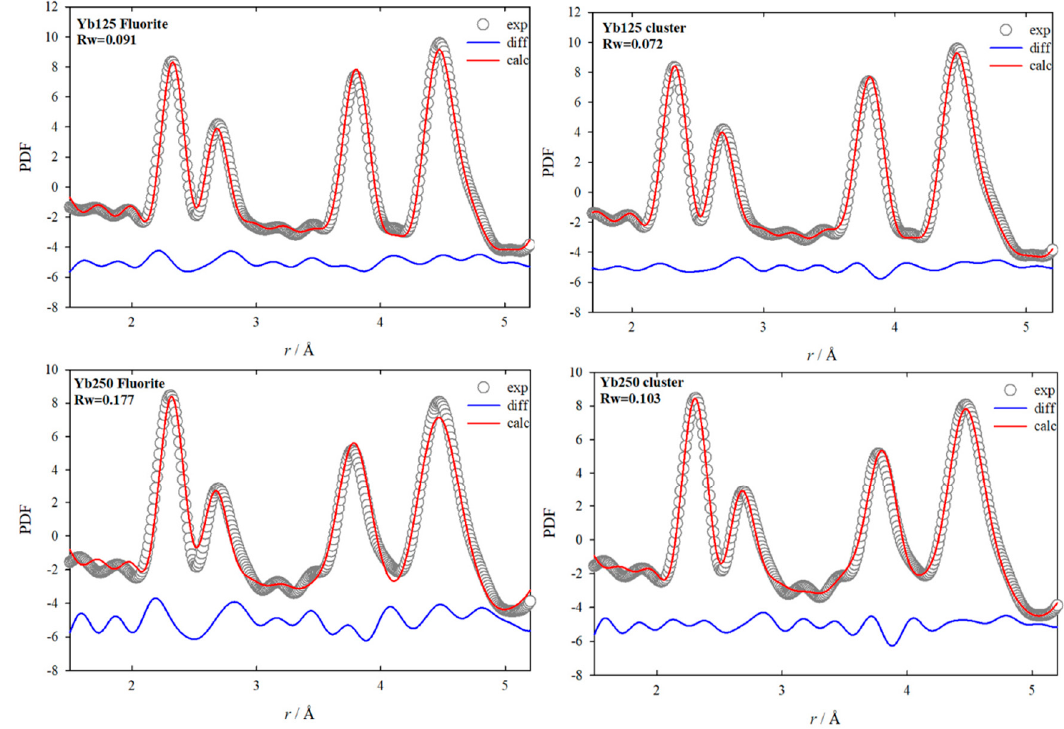
Figure 5. PDF refinements against neutron data of specimens Yb125 ( top panels ) and Y250 ( bottom panels ) by using a simple fluorite model ( left panels ) and a modified model accounting for relaxations ( right panels ). Empty circles: Experimental data; red solid line: Calculated; blue solid line: Difference curve. Table 3. Results of the refinements of neutron PDF curves.